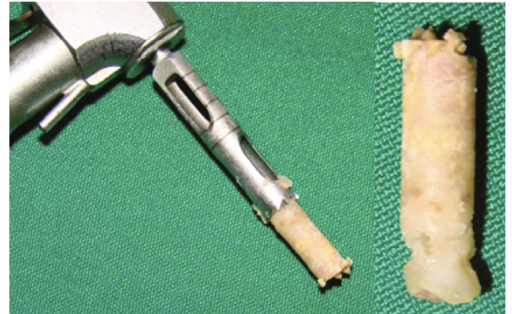
Figure 4: Picture of the bone fragments collected from the grafted areas for histological study.